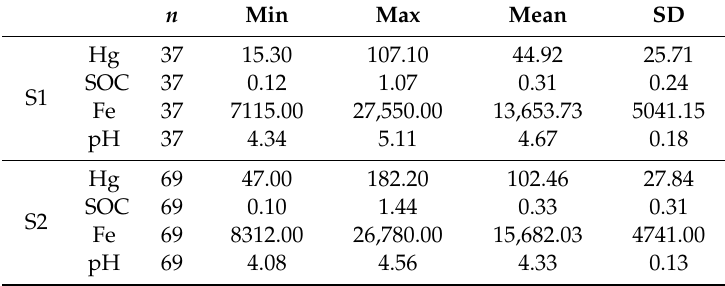
Table 2. Statistics of the data for Hg ( μ g ∙ kg − 1 ), soil organic carbon (SOC—%), Fe (mg ∙ kg − 1 ), and pH (in unit).